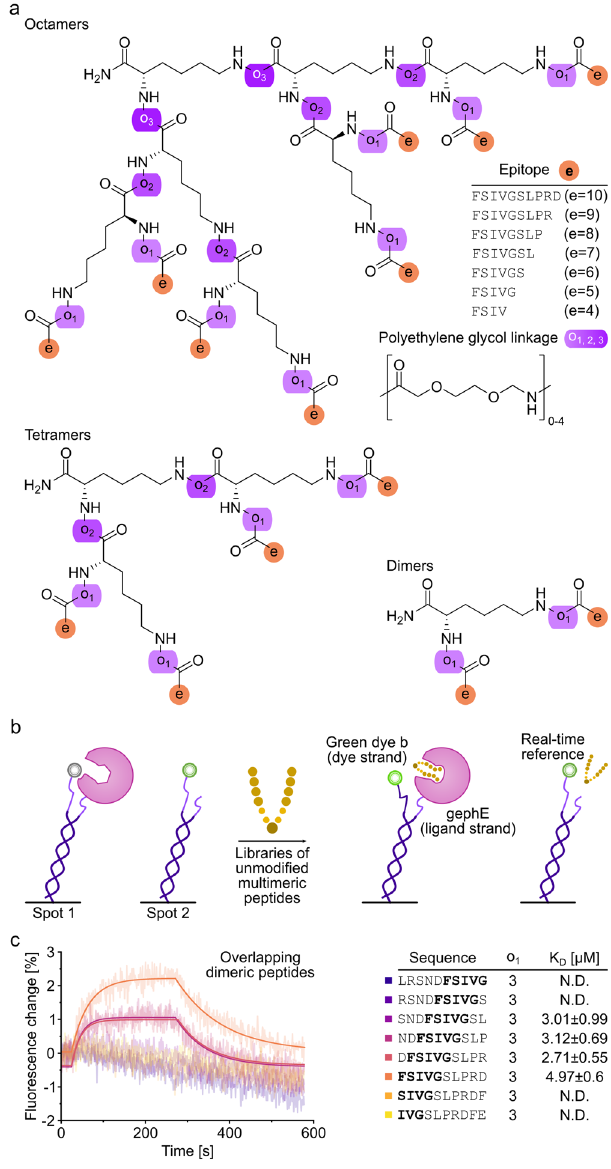
Fig. 1 Multivalent peptide architectures, FPS setup and PPI mapping. a Architecture of multimeric geph-binding peptides. An (Fmoc)-L- Lys(Fmoc) building block facilitated multimerization of geph-binding epitopes, linked together by PEG moieties (o 1-3 ), yielding dimeric, tetrameric and octameric peptides. b schematic representation of FPS measurements. The receptor-binding domain of the neuronal scaffolding protein gephyrin (gephE) is immobilized on the ligand strand via an NHS coupling. The binding of unmodi fi ed, multimeric peptides during the association phase is detected by a change in fl uorescence of green dye b. Note that a real-time reference on spot 2 is used to control for unspeci fi c binding or in fl uence on the fl uorophore ( c ) Real-time af fi nity determination of overlapping, dimeric GlyR β derived peptides in FPS. Peptides were used at a concentration of 1 µ M. Note that only peptides with a centred FSIVG core binding motif exhibited a measurable af fi